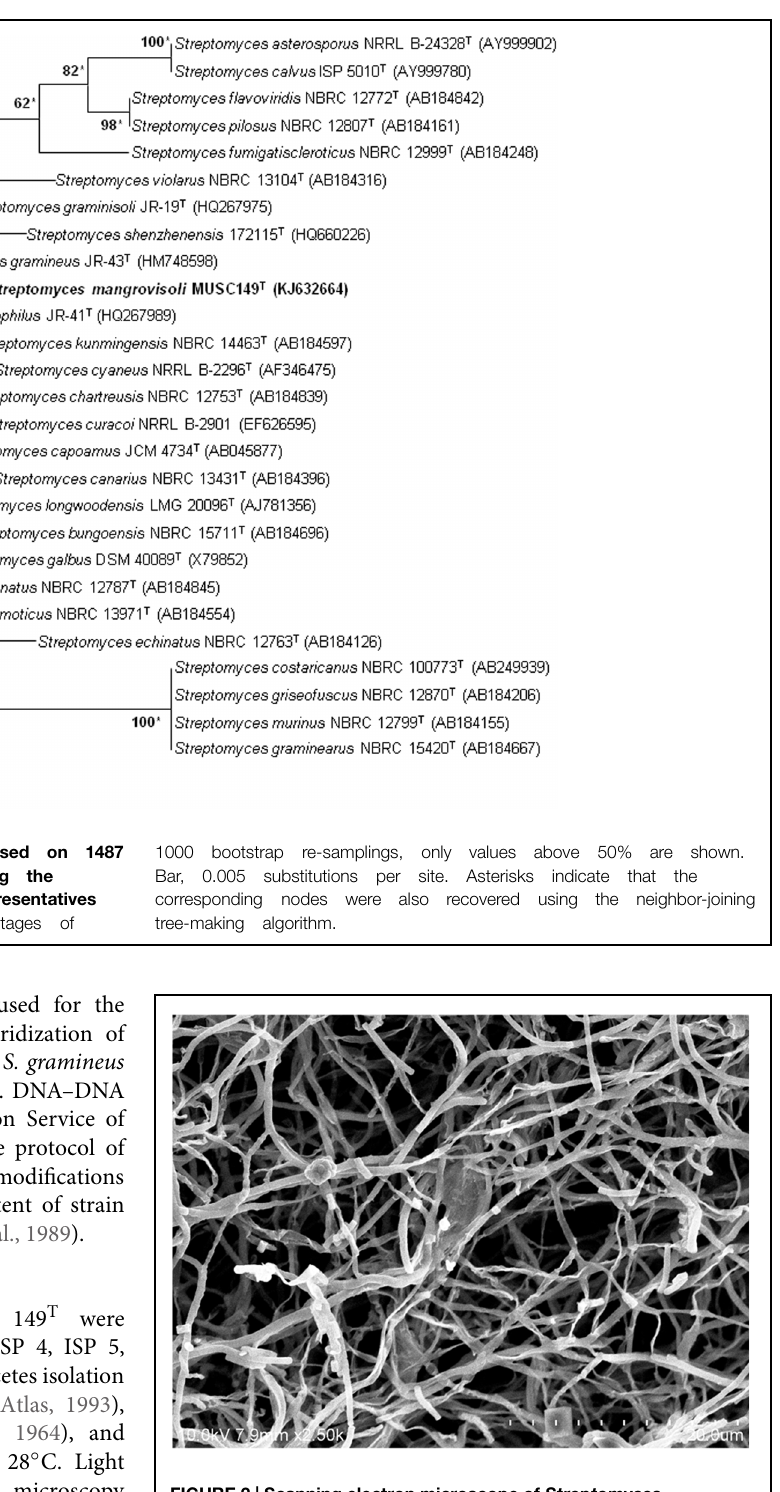
confirmed by using KOH lysis (Cerny, 1978). The growth temperature range was tested at 4-40 ◦ C at intervals of